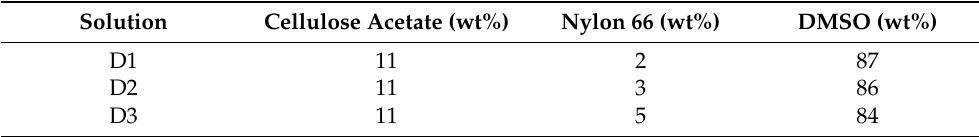
Table 1. Composition (wt%) of the developed membrane using Dimethyl Sulfoxide (DMSO) as a solvent.